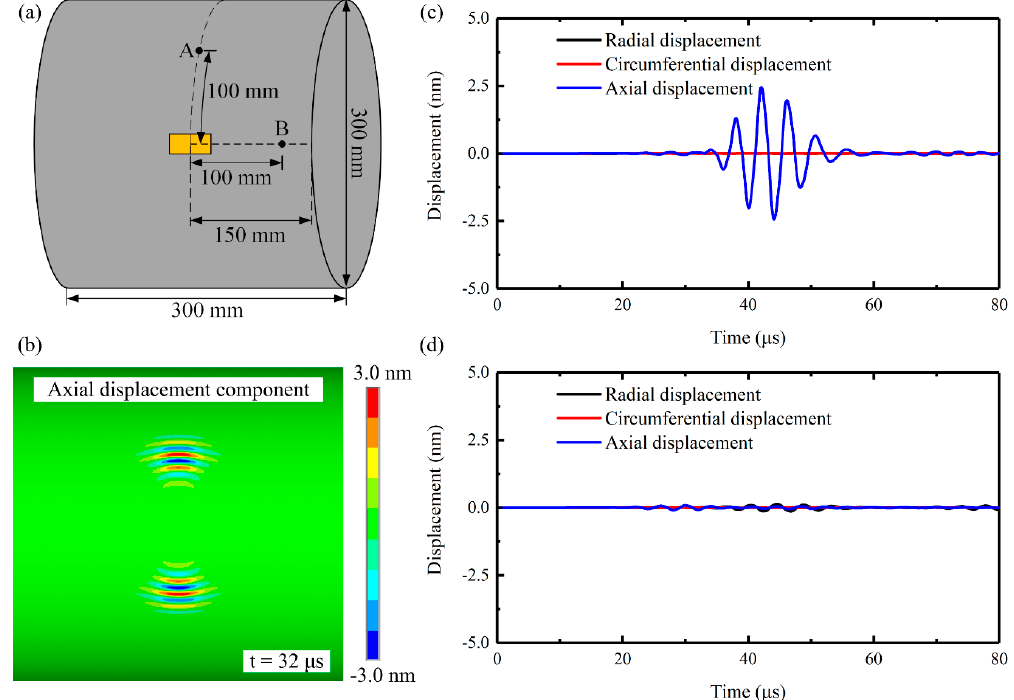
Figure 5. Numerical verification of pure CSH 0 wave excitation by a single surface-bonded piezoelectric transducer at 0.25 MHz·mm in a steel pipe (outer diameter 300 mm, wall thicknesses 1 mm): ( a ) schematics of the finite element simulation setup, ( b ) axial displacement wavefield (CSH 0 wave), displacements time history extracted from ( c ) point A and ( d ) point B.